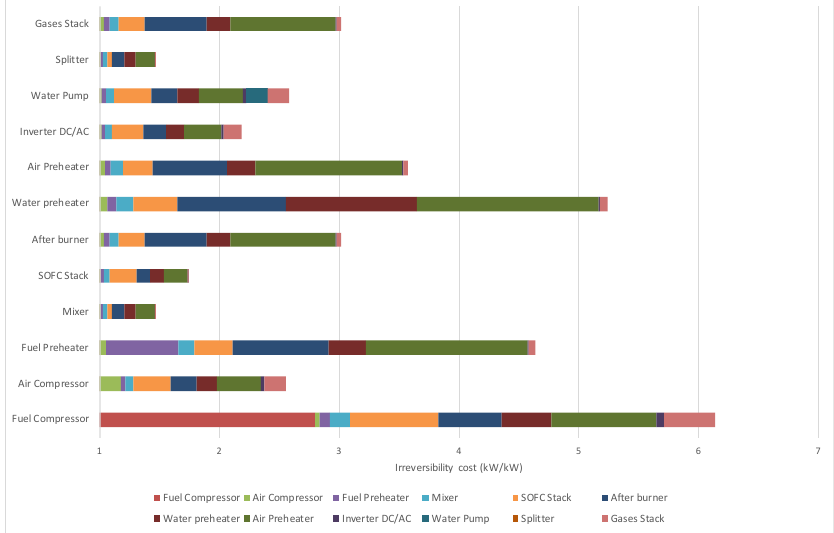
Figure 4. Breakdown of the irreversibility cost by